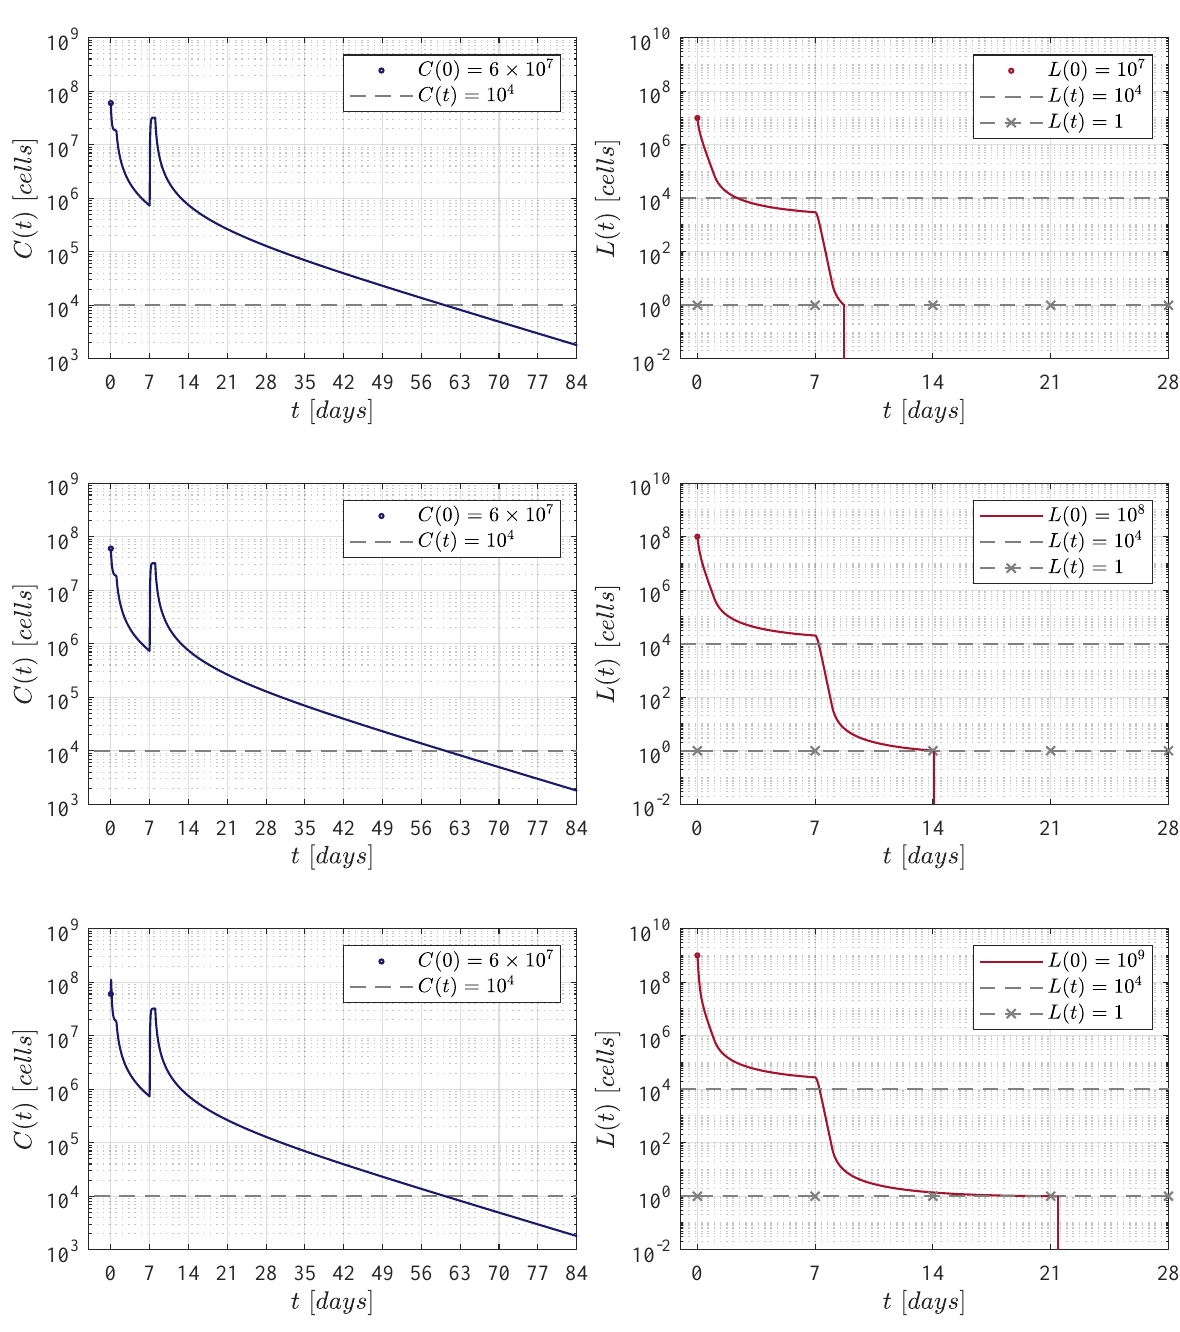
Figure 2. Results determined when applying the Lee et al. [11] therapy administration protocol, i.e., an initial dose of 6 × 10 7 CAR-T cells at day 0, and a second one of 1.8 × 10 8 at day